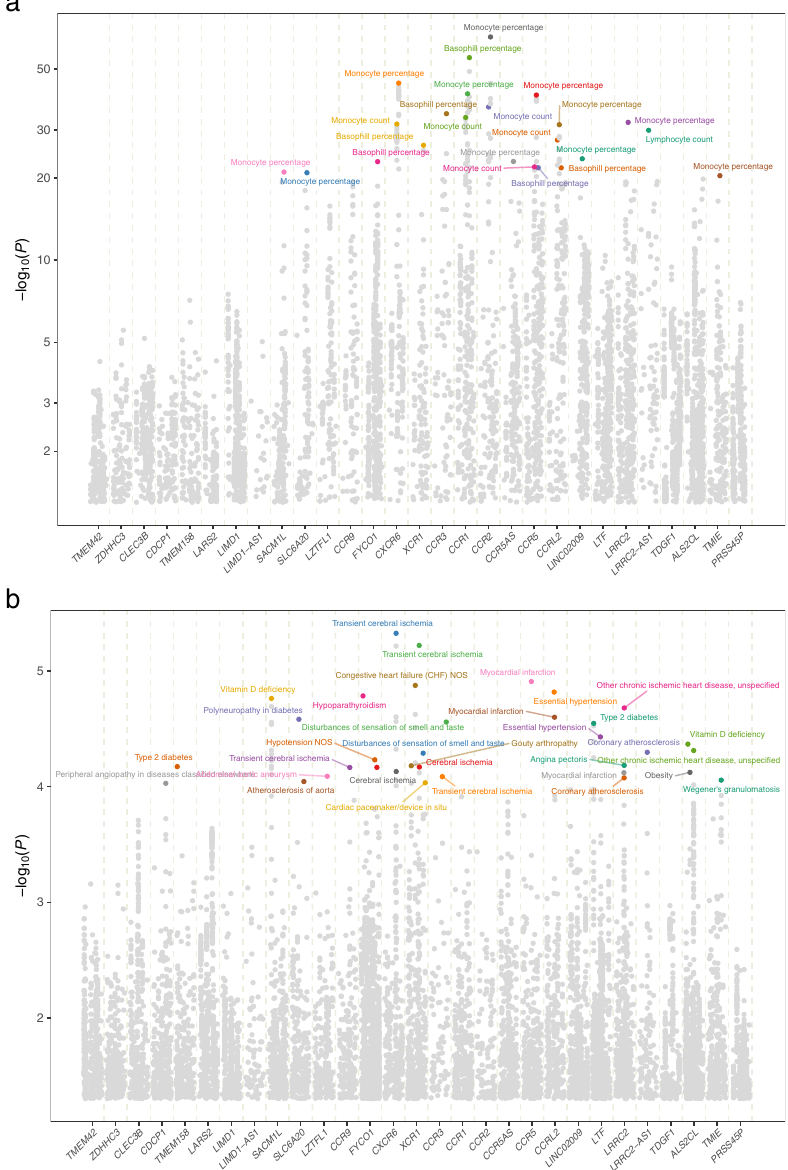
Fig. 6 Region-level Manhattan plot of phenome-wide gene-level associations in the locus. JTI signals for phenome-wide traits, including a blood cell traits and b neurological, respiratory, circulatory, and endocrine/metabolic disorders, were observed in the region near the introgressed segment (within 1 Mb). Only genes imputable by the segment were included in this analysis. The genes are ordered by their physical positions. The minus log P value from the association between the genetically determined expression and the traits is shown. For each gene, only the most signi fi cant tissue is labeled. a For blood cell traits, highly signi fi cant results ( P < 1.0e − 20) are labeled by the trait names. b For potential adverse outcomes, nominally signi fi cant results ( P < 1.0e − 4) are labeled by the trait names. Additional details on the association results can be found in Supplementary Table 11 and Supplementary Table